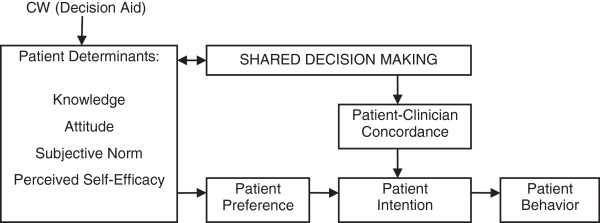
Conceptual model.